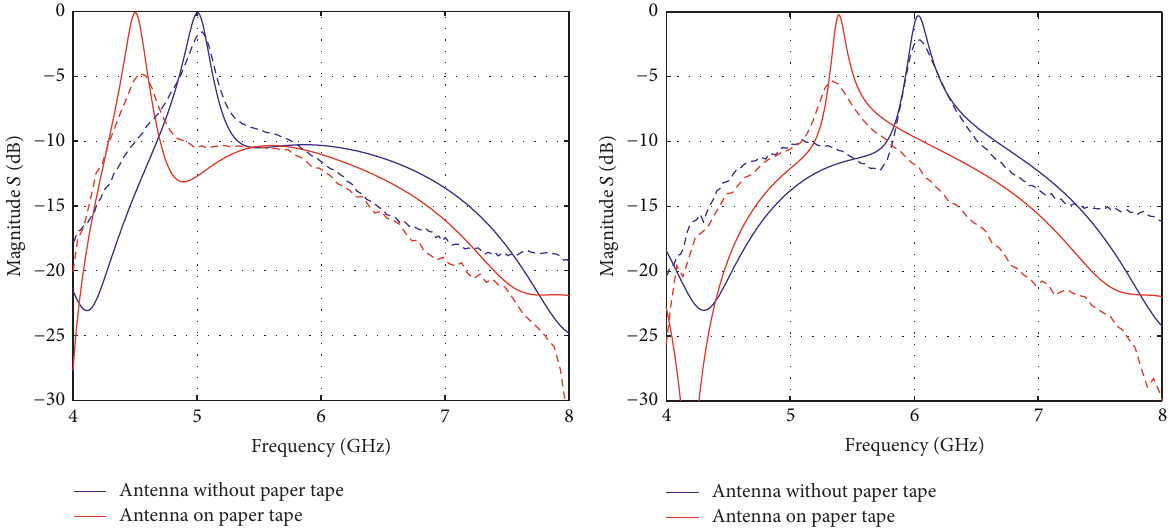
Figure 10: Magnitude of the reflection coefficient for a planar antenna with a notch at frequencies: (a) 𝑓 = 5 GHz, (b) 𝑓 = 6 GHz. Simulation: solid line. Measurement: dashed